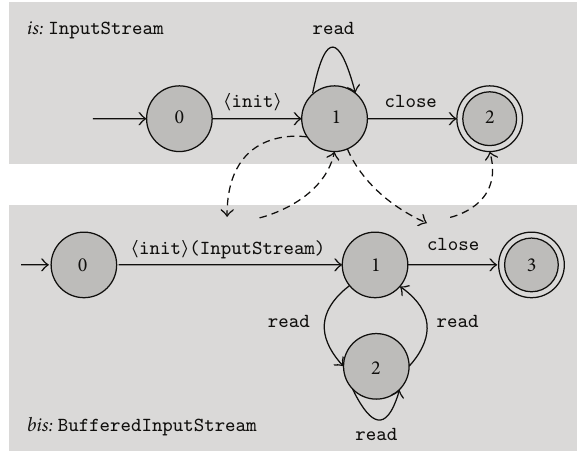
Figure 1: Typestates of interactions between BufferedIn - putStream and its wrapped InputStream mined by our approach. is denotes the above highlighted part of the figure, and bis denotes the below highlighted part of the